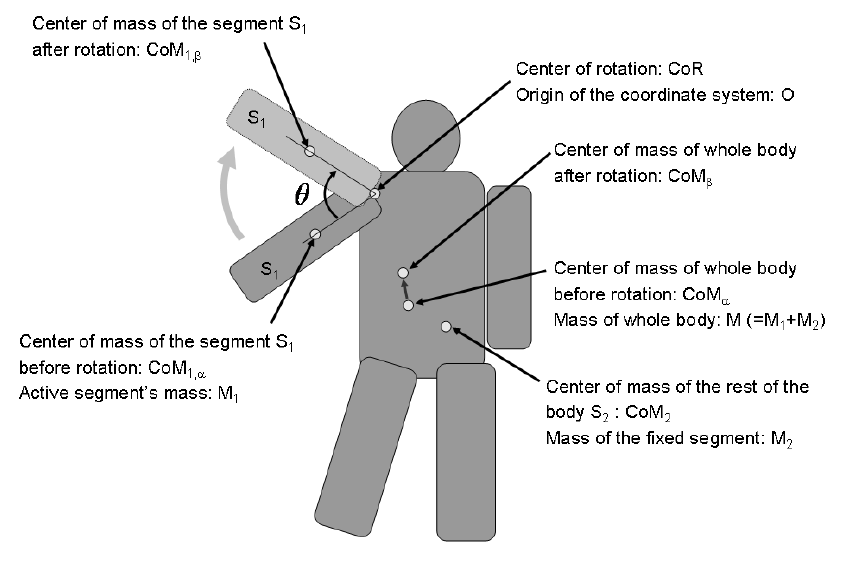
Figure 1. Principle of the method (top-down